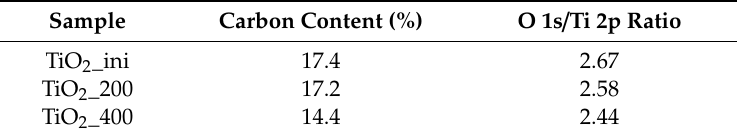
Table 2. Data from the XPS spectra.